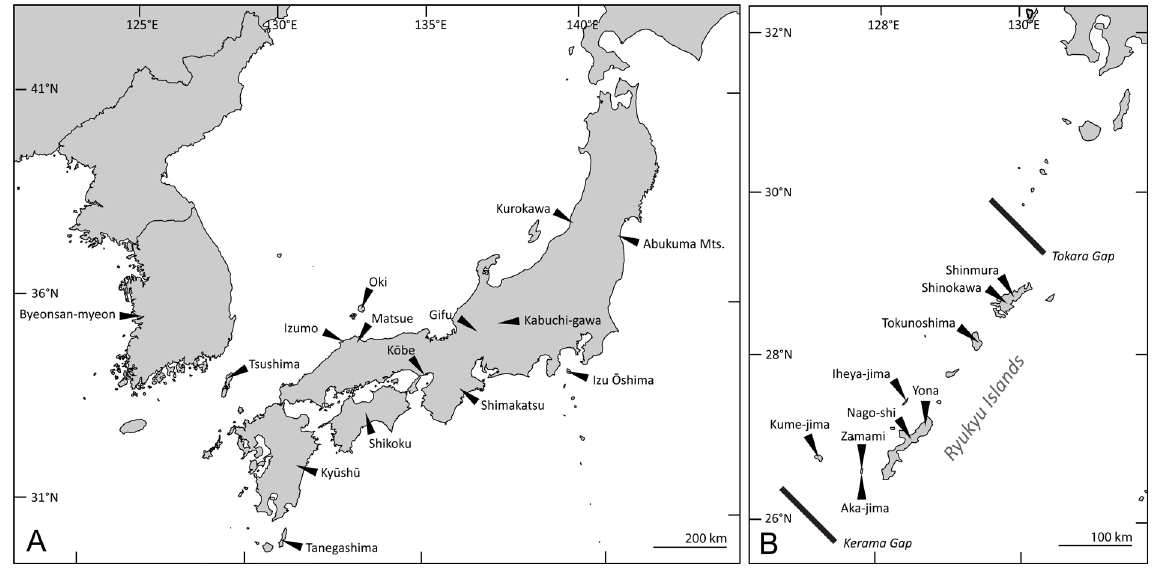
Fig. 10. Map showing records of A . Elmomorphus brevicornis Sharp, 1888. B . Elmomorphus amamiensis Nomura,